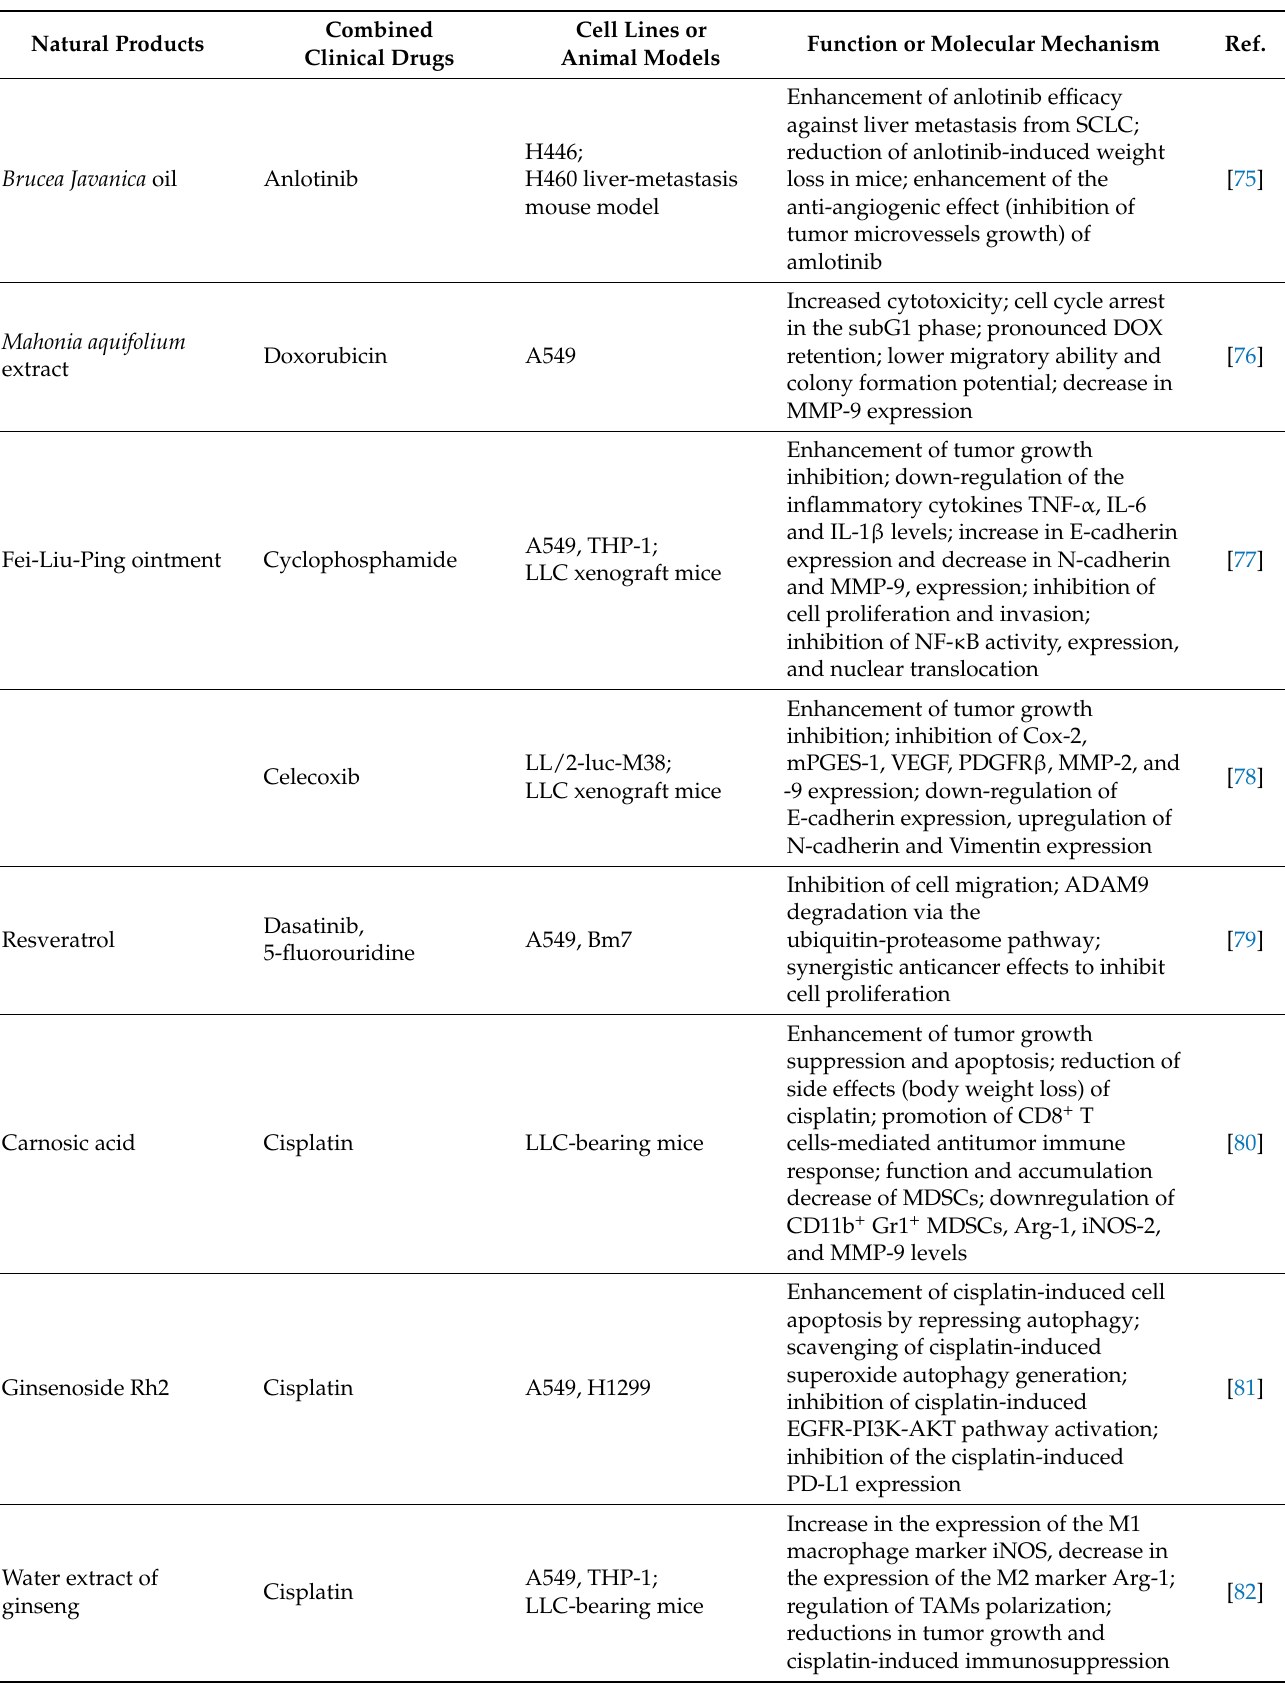
Table 2. The effects of natural products combined with chemotherapy drugs on modulation of the TME. Natural